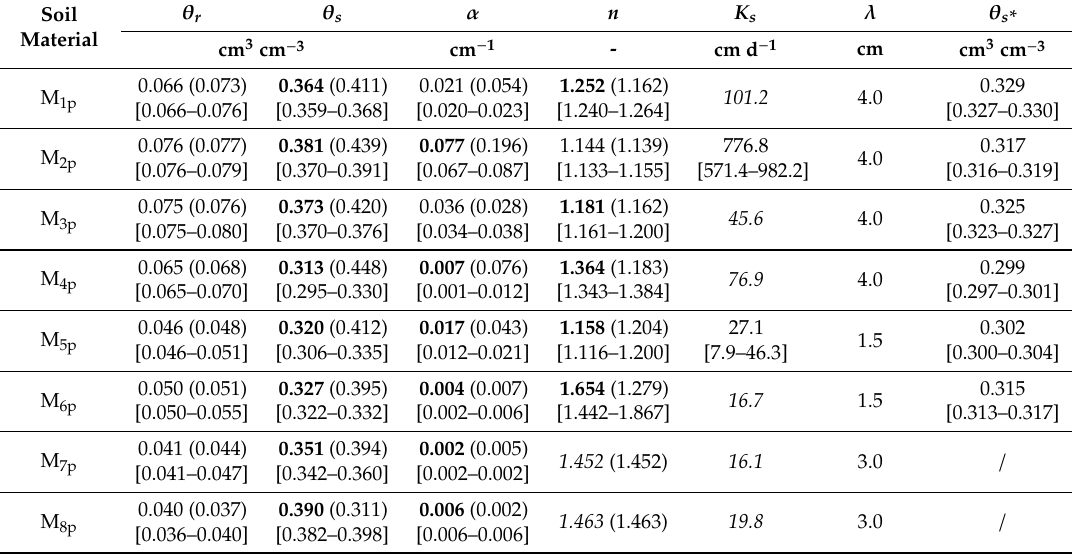
Table 2. Parameters optimized using HYDRUS-1D for each of the eight soil materials of Field Plot 1. Soil